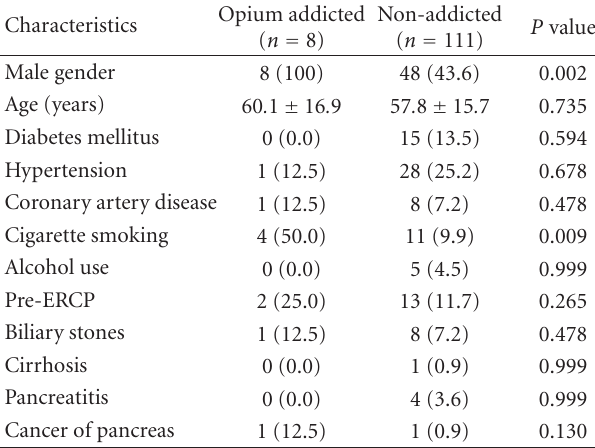
Table 1: Baseline characteristics and medical history in opium- addicted and non-addicted patients with SOD and undergoing ERCP.